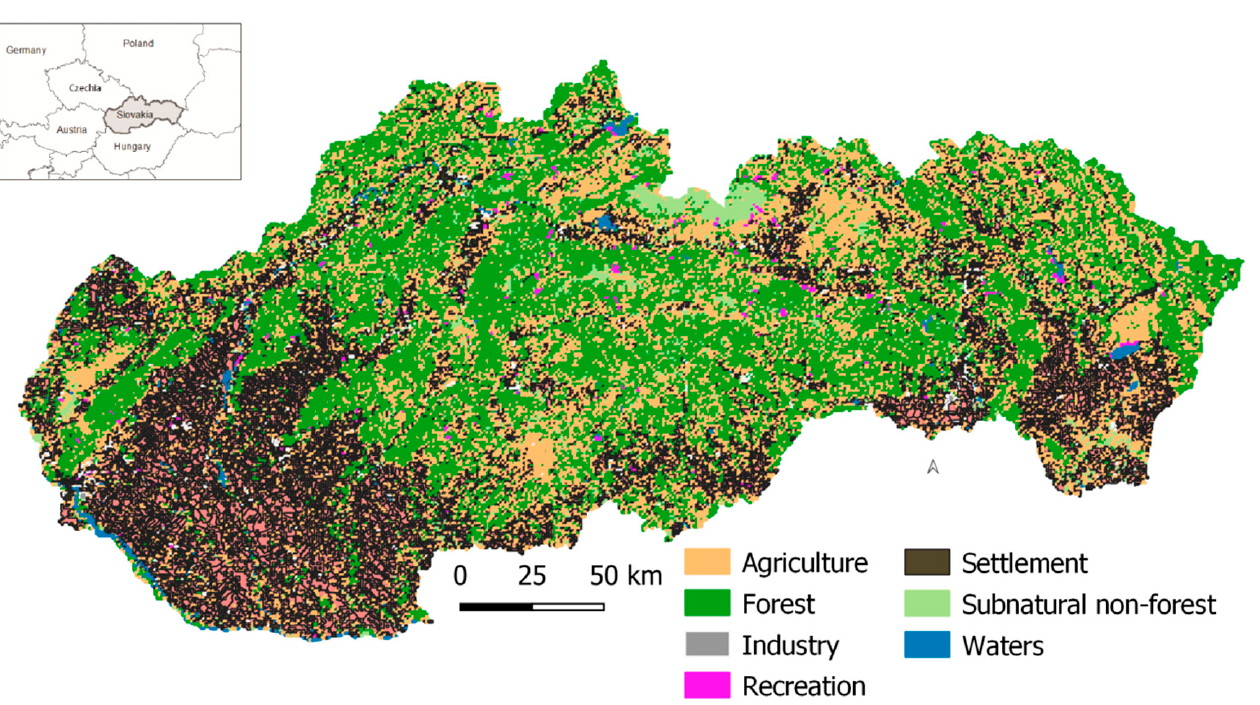
Figure 3. Study area of Slovakia—the main land use.